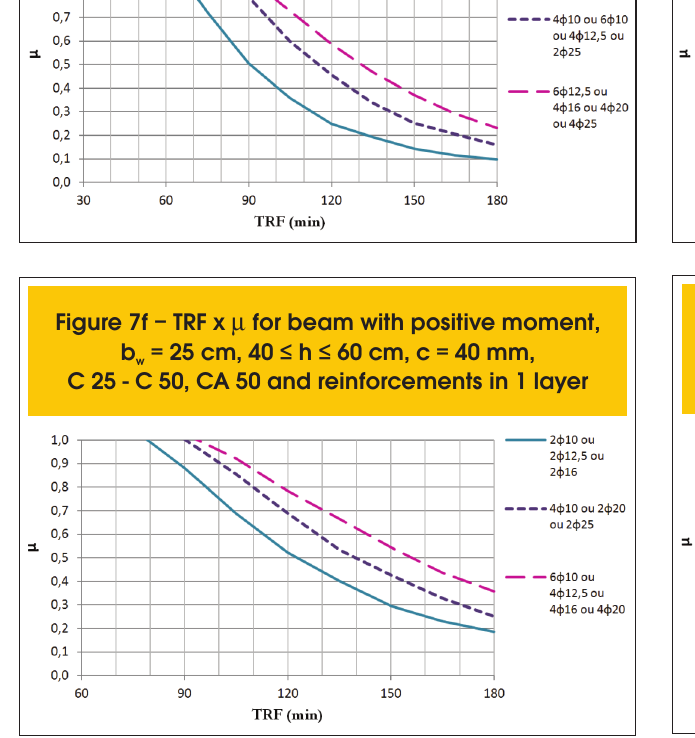
Figure 8d – TRF x m for beam with negative moment, b = 19 cm, 50 ≤ h < 60 cm, c = 25 mm, w C 25 - C 50, CA 50 and reinforcements in 1